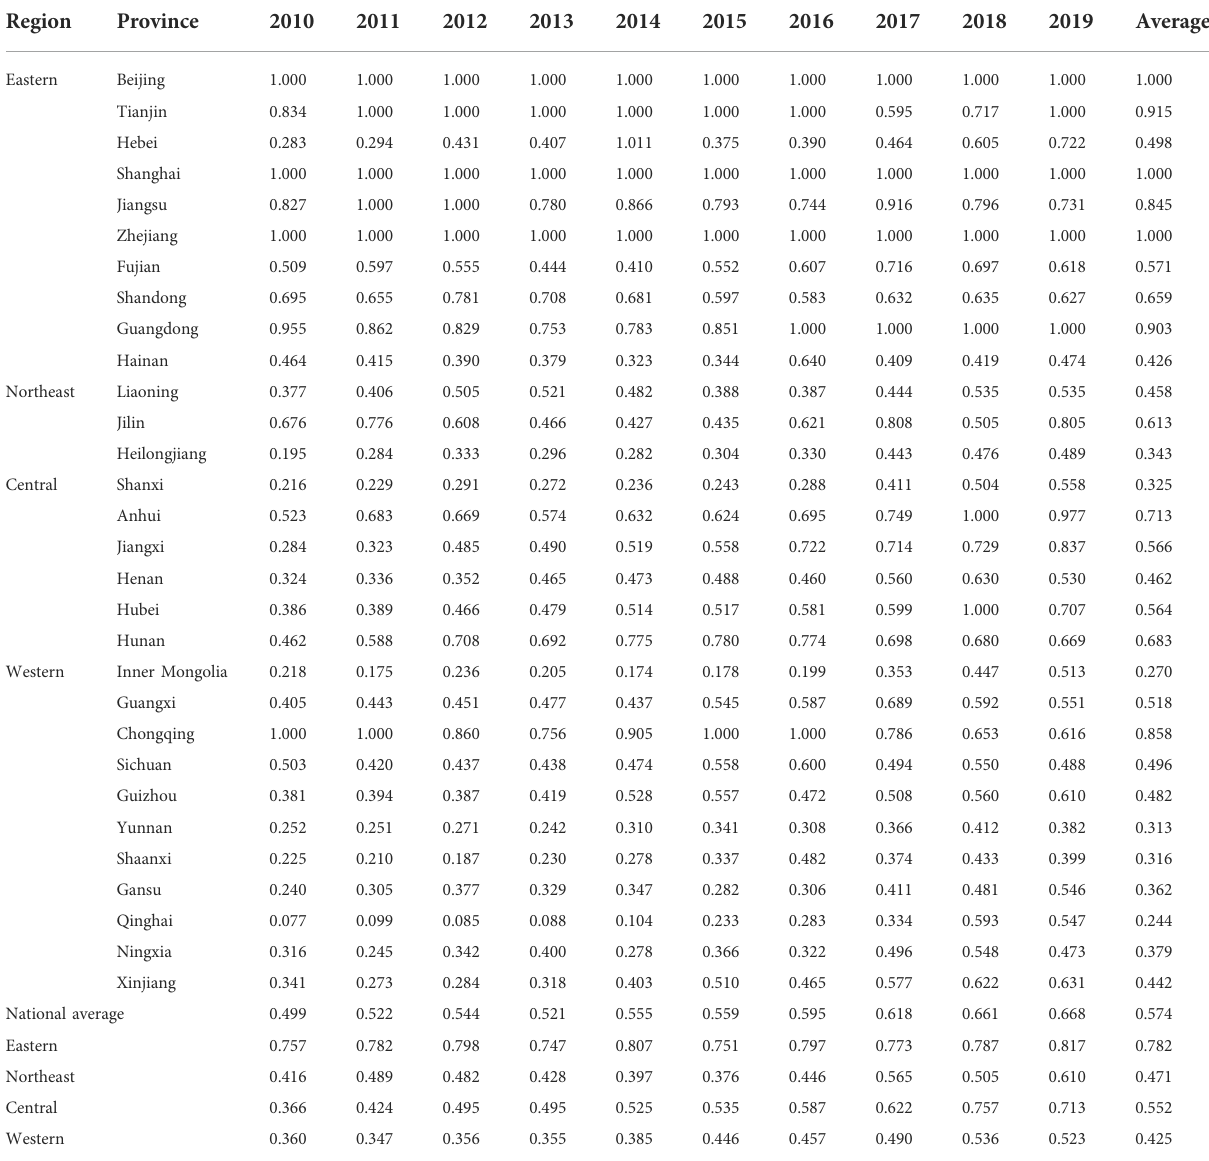
TABLE 4 Evaluation values of GIE in 30 provinces in China from 2010 to 2019.